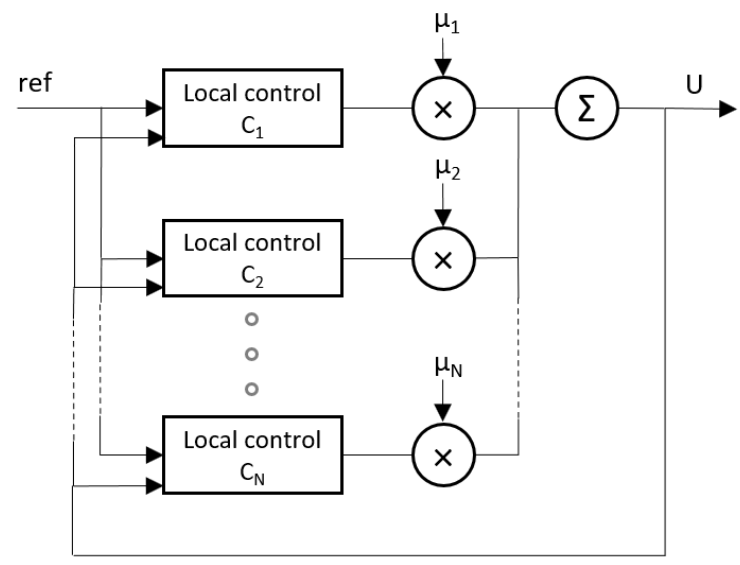
Figure 5. Control structure with local models.